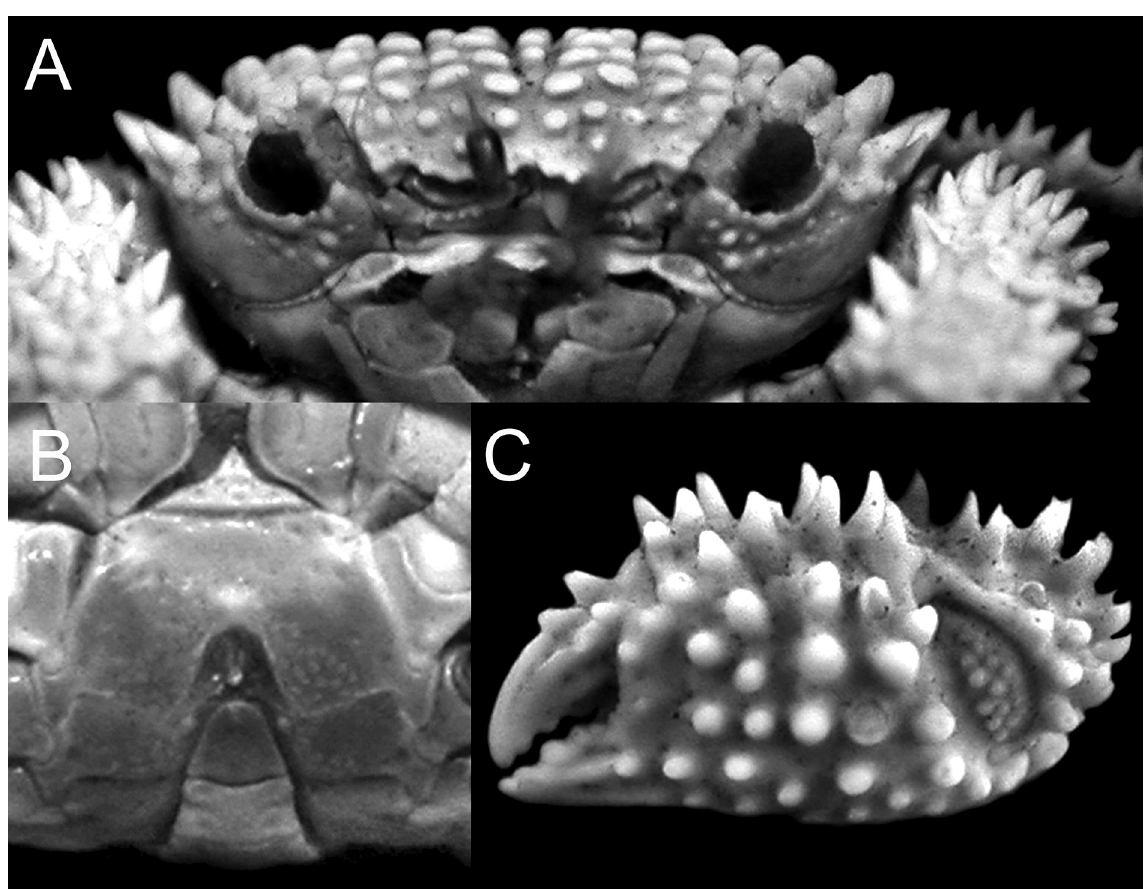
Fig. 7. Actaea spinosissima Borradaile, 1902, holotype, ♂, 5.1 × 3.4 mm (CUMZ I.63106), Maldives. A . Frontal view of carapace. B . Anterior thoracic sternum (sternites 1–4), telson and abdominal somite 6. C . Outer view of left